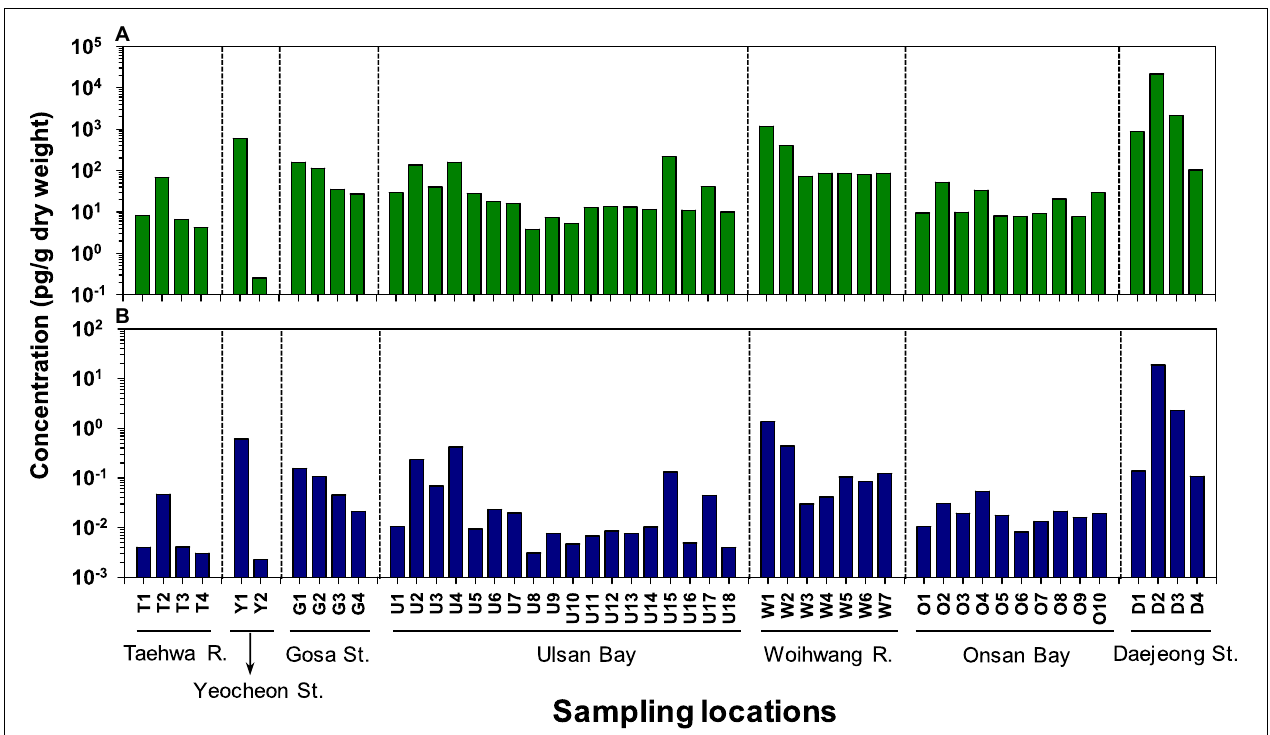
FIGURE 2 | Spatial distribution of (A) total and (B) toxic equivalent (TEQ) concentrations of polychlorinated naphthalenes (PCNs) in sediment collected from Ulsan and Onsan Bays and their inflowing rivers and streams, Korea.